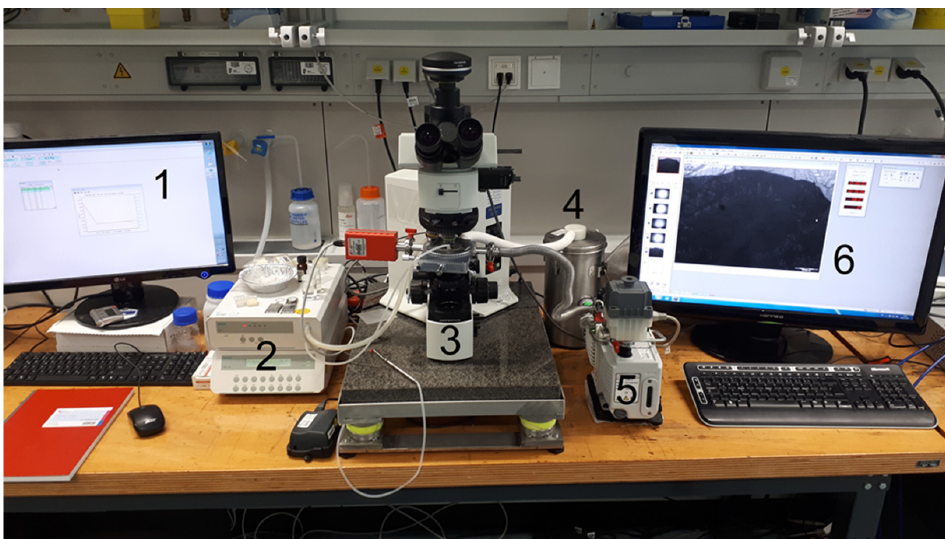
Figure 1. Experimental setup of the lyomicroscope: ( 1 ): Computer to controll the freeze-drying stage; ( 2 ) Liquid nitrogen pump; ( 3 ) microscope with mounted freeze-drying stage; ( 4 ) liquid nitrogen container; ( 5 ) vacuum pump; ( 6 ) computer for imaging.